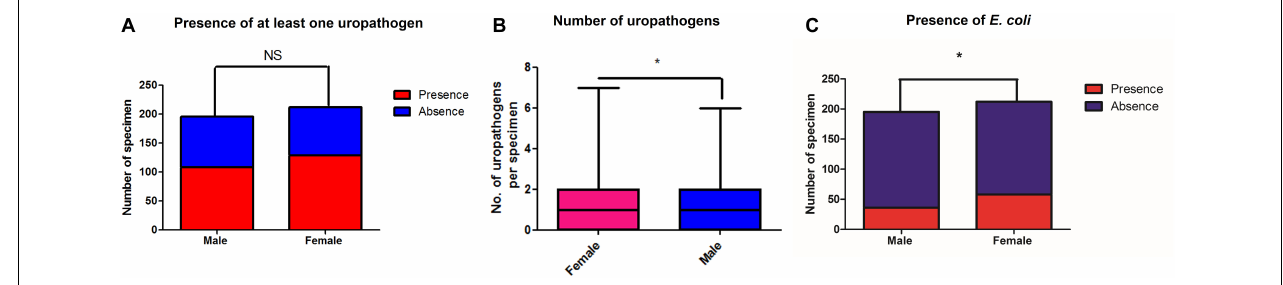
FIGURE 2 | Number of specimens for which at least one uropathogen (A) and E. coli (C) were recovered by culture in this study, respectively, among male and female patients. (B) highlights the median number of uropathogens cultured per sample among men and women. * p < 0.05.